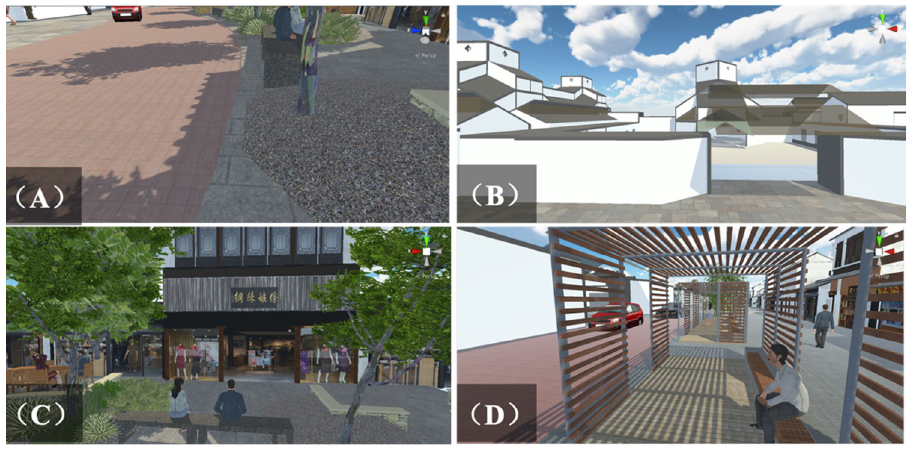
Fig 3. Visualization in unity